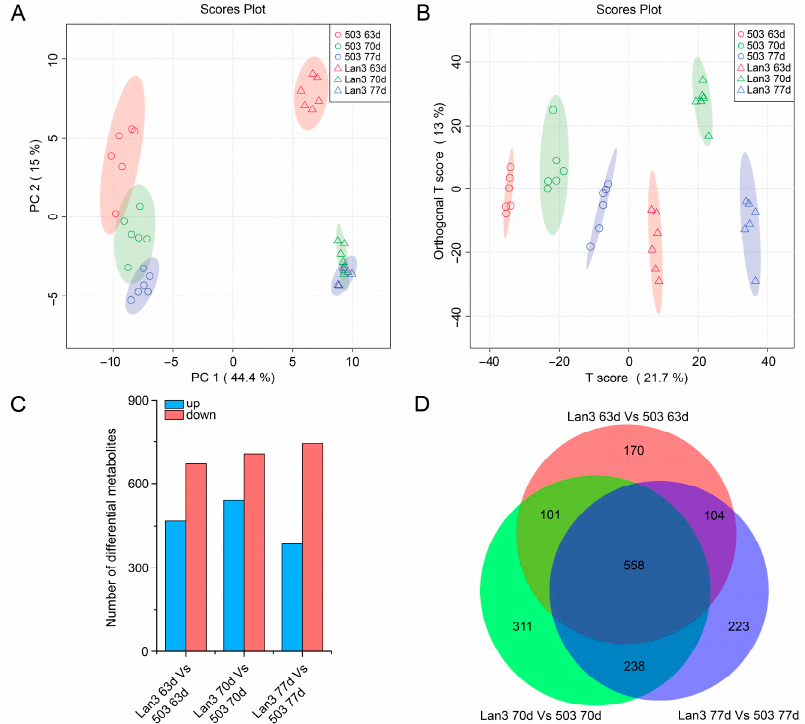
Figure 5. Summary of the differential metabolites between Lan3 and 503. ( A ) Principal component analysis score plot. ( B ) Orthogonal partial least squares discrimination analysis score plot. ( C ) A summary of the numbers of up- and down-regulated differential metabolites 63, 70, and 77 DAS.